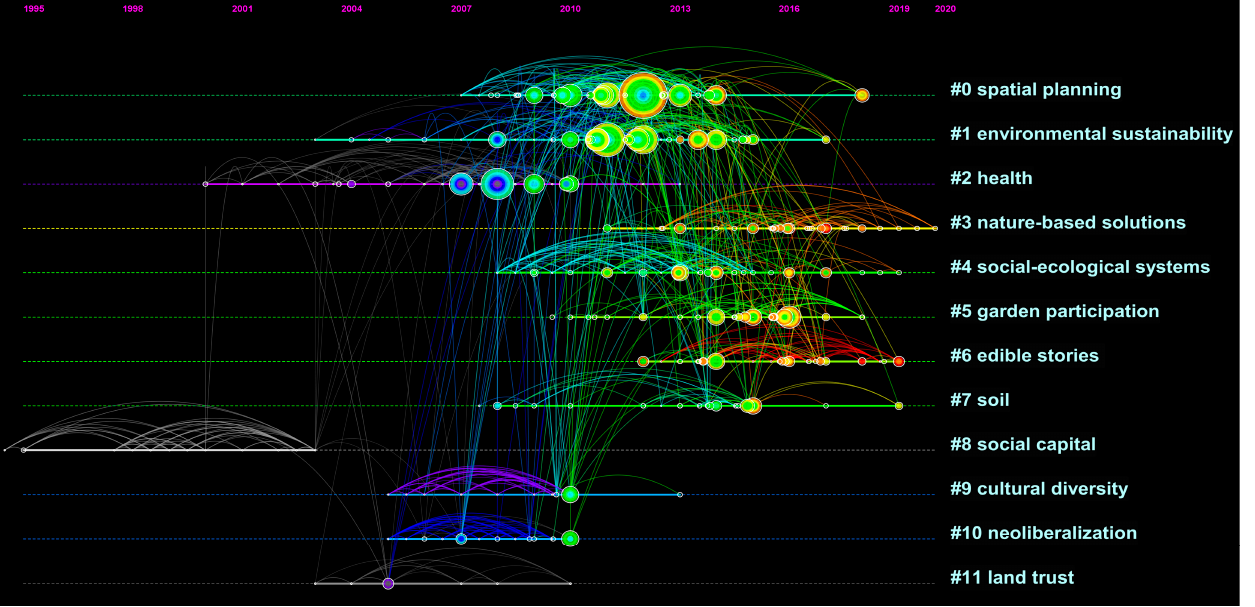
Figure 8. Timeline visualization of the co-citation clusters. The legend above the display area is marked every 3 years. Clusters are displayed horizontally along timelines and the label of each cluster is shown at the end of the cluster’s timeline.